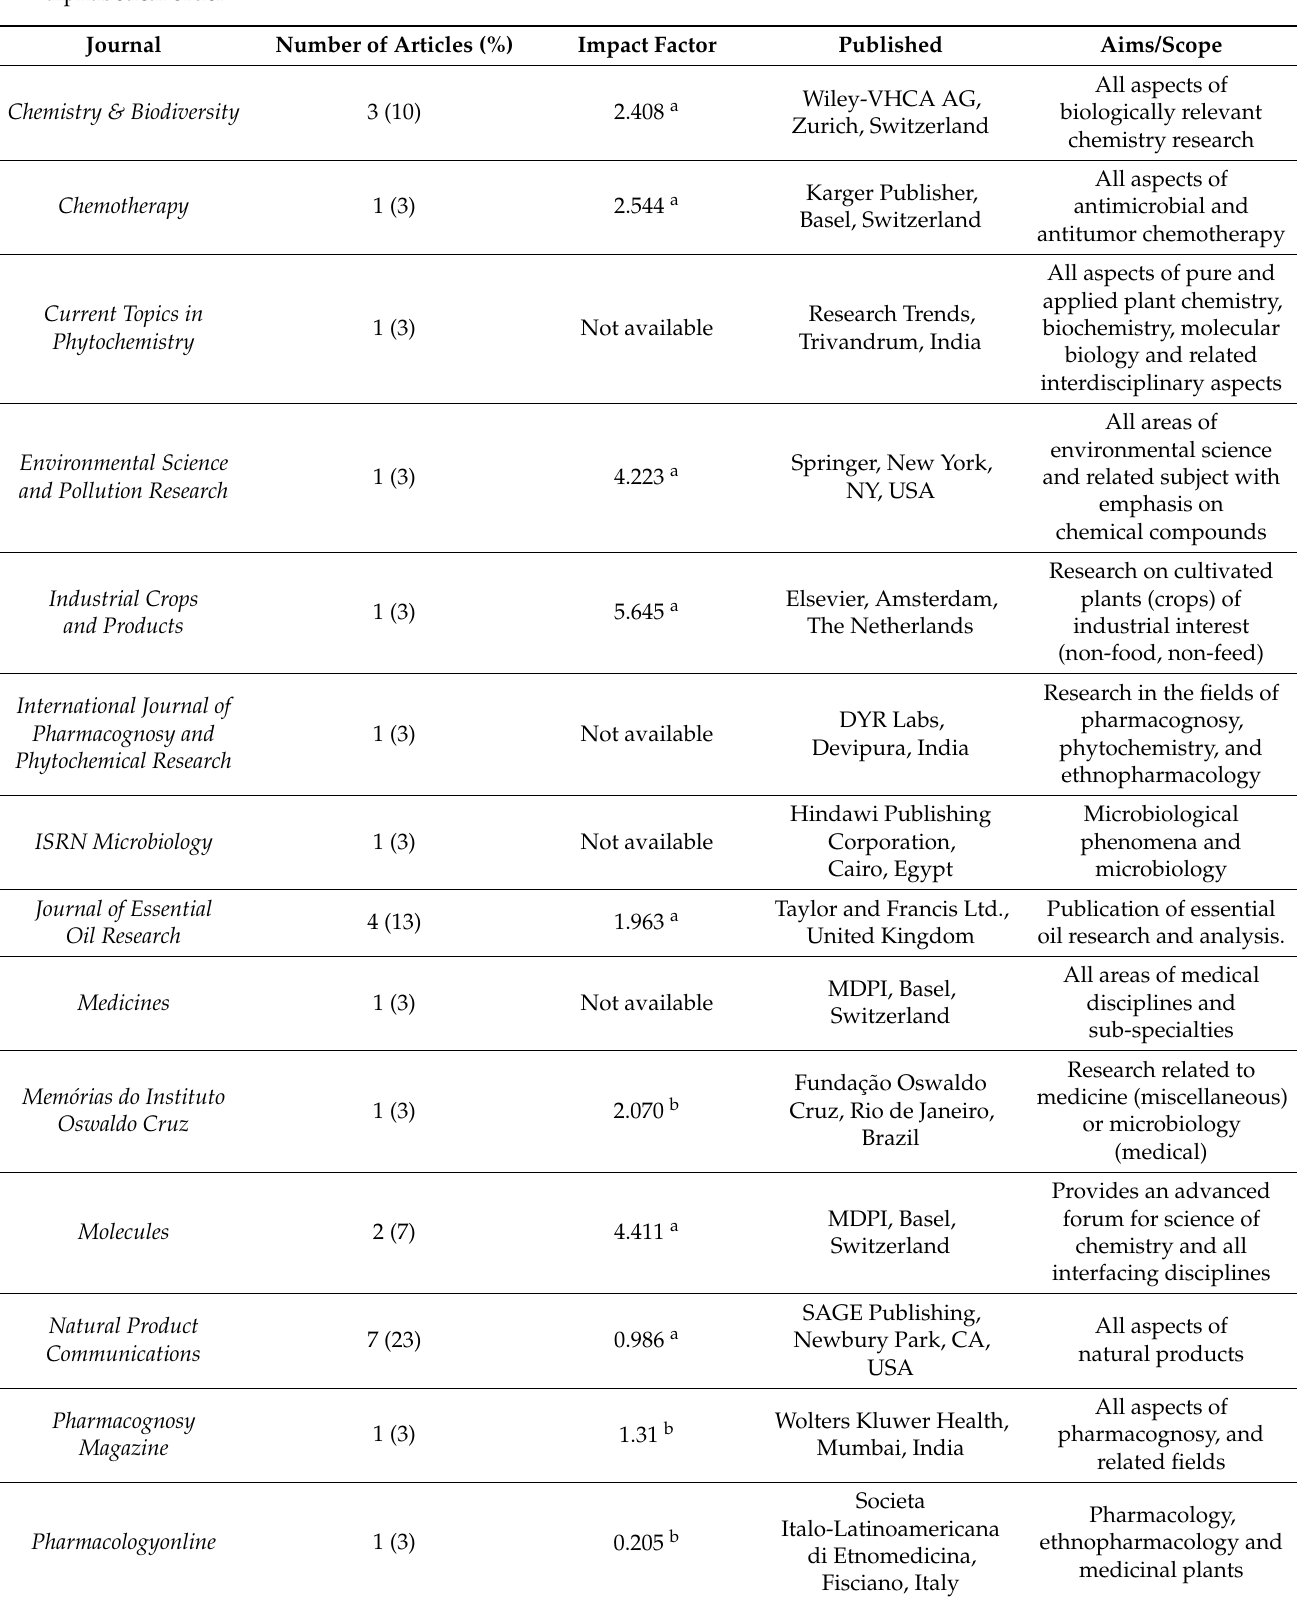
Table 1. Journals that published articles related to essential oils from Cuban plants included in this review, listed in alphabetical